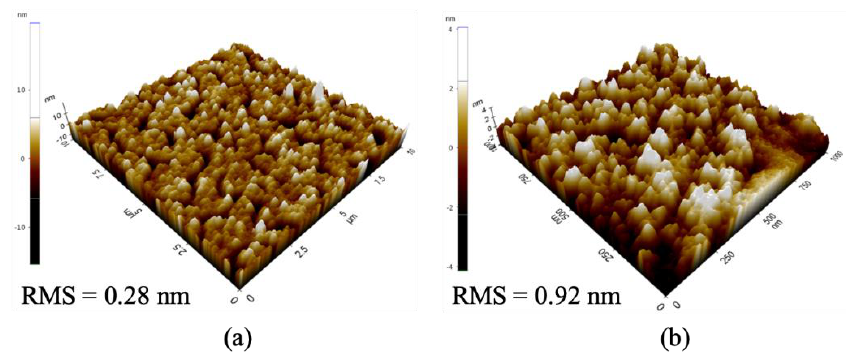
Figure 6. AFM image of. ( a ) QDs only, ( b ) QDs in the Al 2 O 3 thin film.